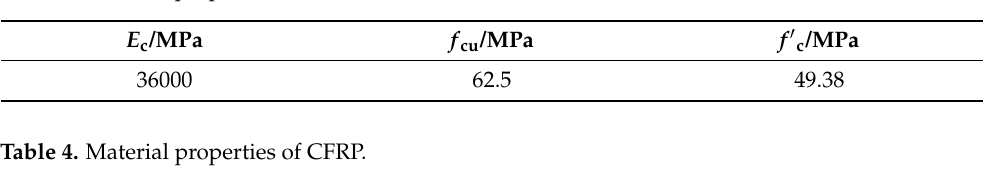
Table 3. Material properties of concrete.